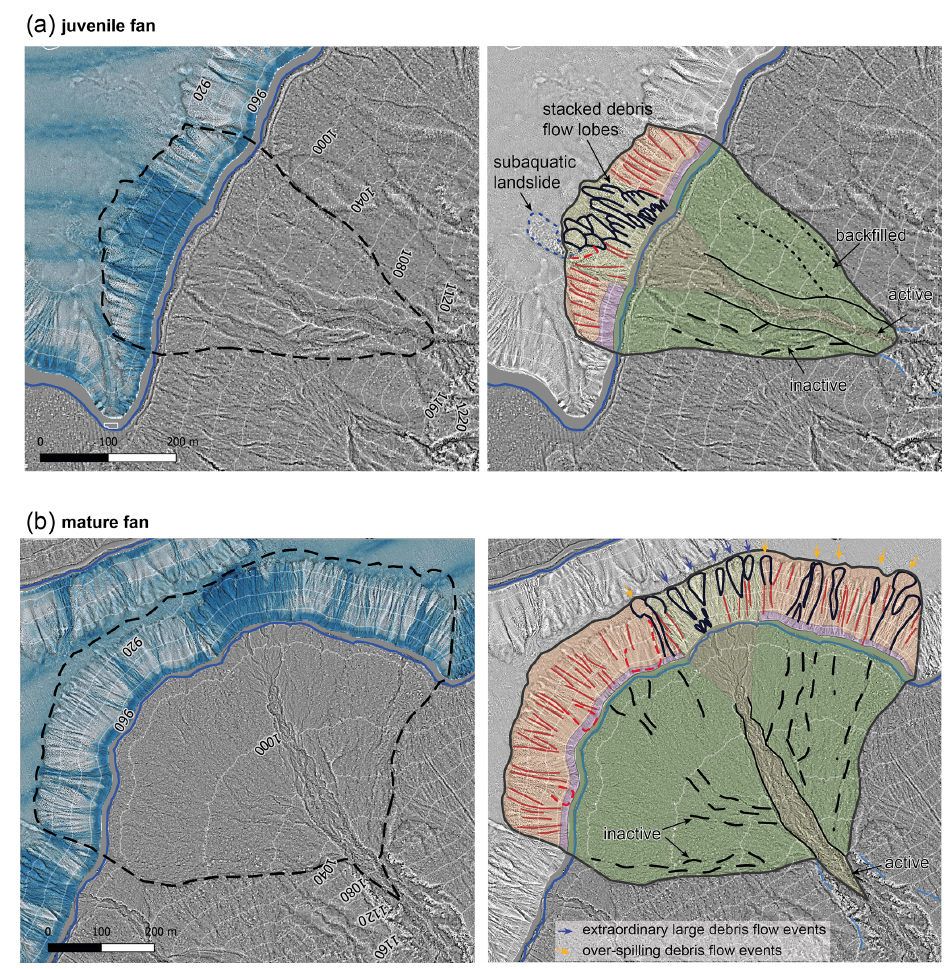
Figure 3. Topographic openness difference maps of the juvenile (a) and mature (b) fan deltas (left) and their geomorphic interpretation (right). The steep and small juvenile fan (a) has a channel backfilled with sediment, a currently inactive channel, and a distinct active channel cut into previous fan deposits. The active subaquatic fan delta shows numerous stacked debris flow lobes and a subaquatic delta failure in form of a subaquatic landslide. The large and flat mature fan (b) shows a distinct active channel several diffuse inactive channels beside it. Subaquatic debris-flow-induced turbidites (df turbidites) along diffuse inactive channels are interpreted as debris flow events spilling over the currently active channel levee (orange arrows). The active fan delta is composed of only few df turbidites at the basal slope in the elongation of gullies interpreted as extraordinary large debris flow events (blue arrows). A detailed legend is provided in Fig. 2. Onshore DEM is derived from Land Tirol (https://data.tirol.gv.at, last access: 31 January